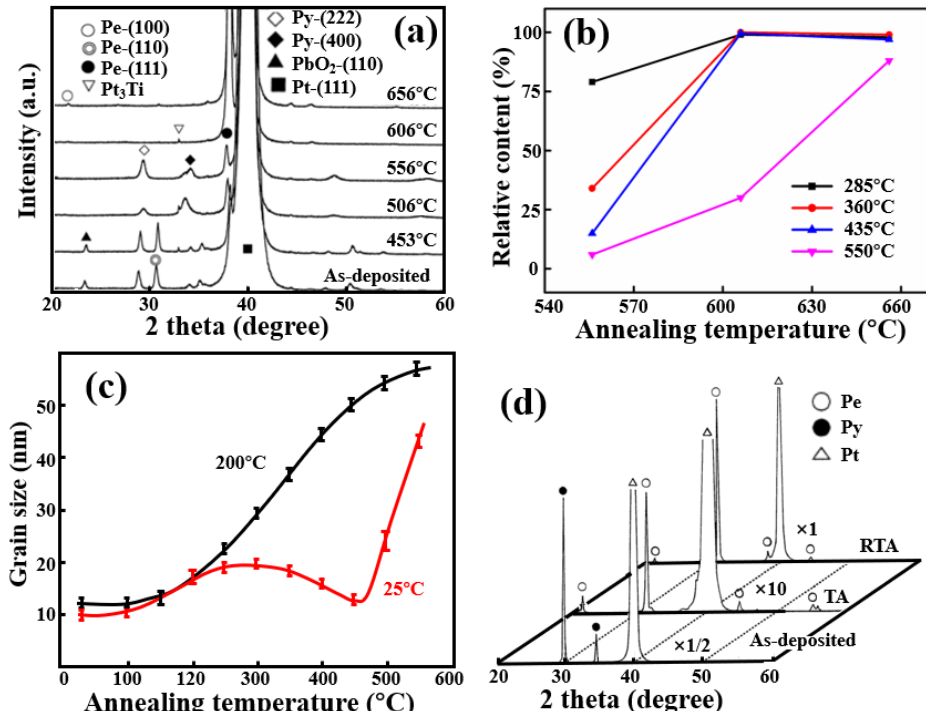
Figure 7. ( a ) XRD patterns of PZT thin films annealed at different temperatures. Reprinted with permission from [45] Copyright 2000 Elsevier; ( b ) correlations among deposition temperature, annealing temperature and relative content of perovskite phase in total phases of the PZT thin films. Reprinted with permission from [45] Copyright 2000 Elsevier; ( c ) grain size as a function of annealing temperature for PZT thin films deposited at different temperature (25 and 200 °C). Reprinted with permission from [55] Copyright 1989 Elsevier; ( d ) XRD patterns of as-deposited (×1/2), TA treated (×10) and RTA treated (×1) PZT thin films. Reprinted with permission from [56] Copyright 1993 The Physical Society of Japan and The Japan Society of Applied Physics.